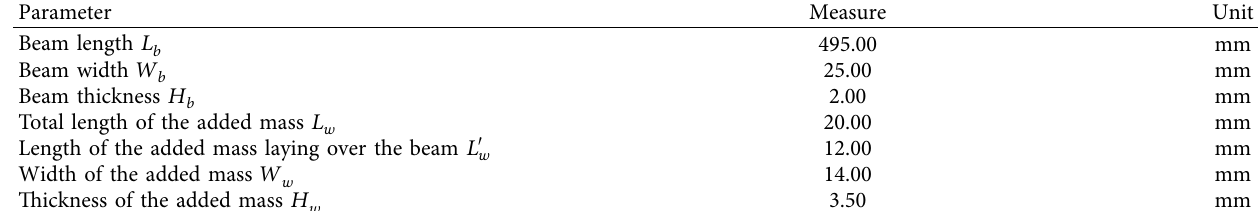
Table 6: Geometry of the beam and the added mass.